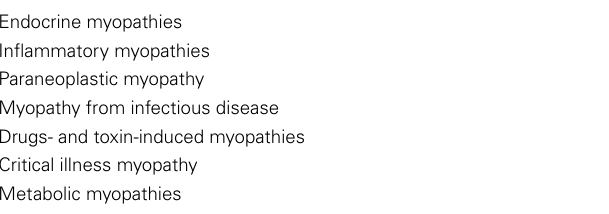
Table 1 | Classification of myopathies with systemic